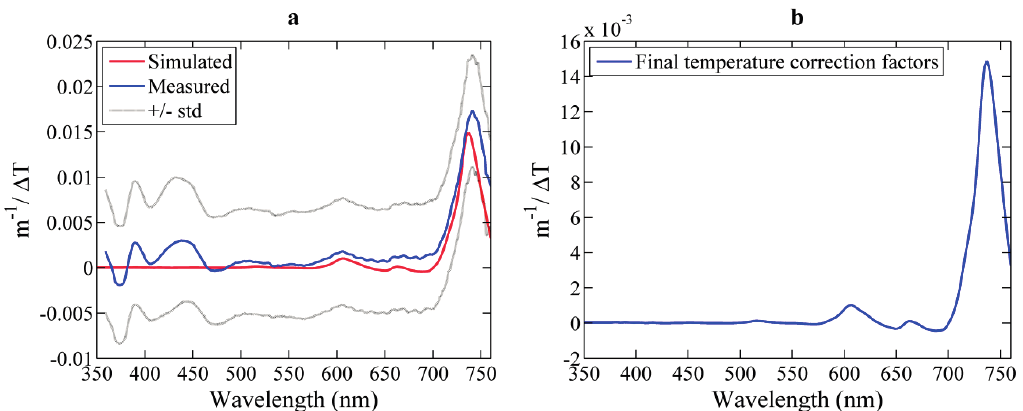
Figure 7. ( a ) Results from the temperature dependence analysis and the comparison with model simulations based on the approach by Max and Chapados [35] (red line). The blue line corresponds to the average over the 20 experimental runs and the standard deviation is represented with dotted line; ( b ) Final VIPER-specific temperature correction coefficient for pure water beam attenuation as a function of the